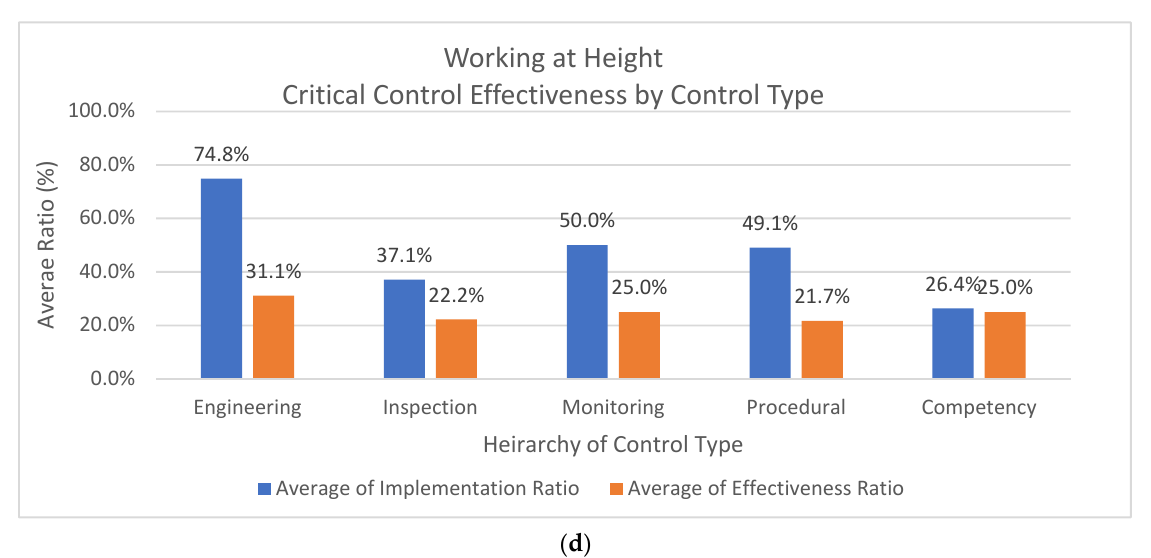
Figure 7. ( a ) Lifting Operations CC performance by Hierarchy of Control; ( b ) Mobile Plant and Equipment CC performance by Hierarchy of Control; ( c ) Stored Energy CC performance by Hierarchy of Control; ( d ) Working at Height CC performance by Hierarchy of Control.